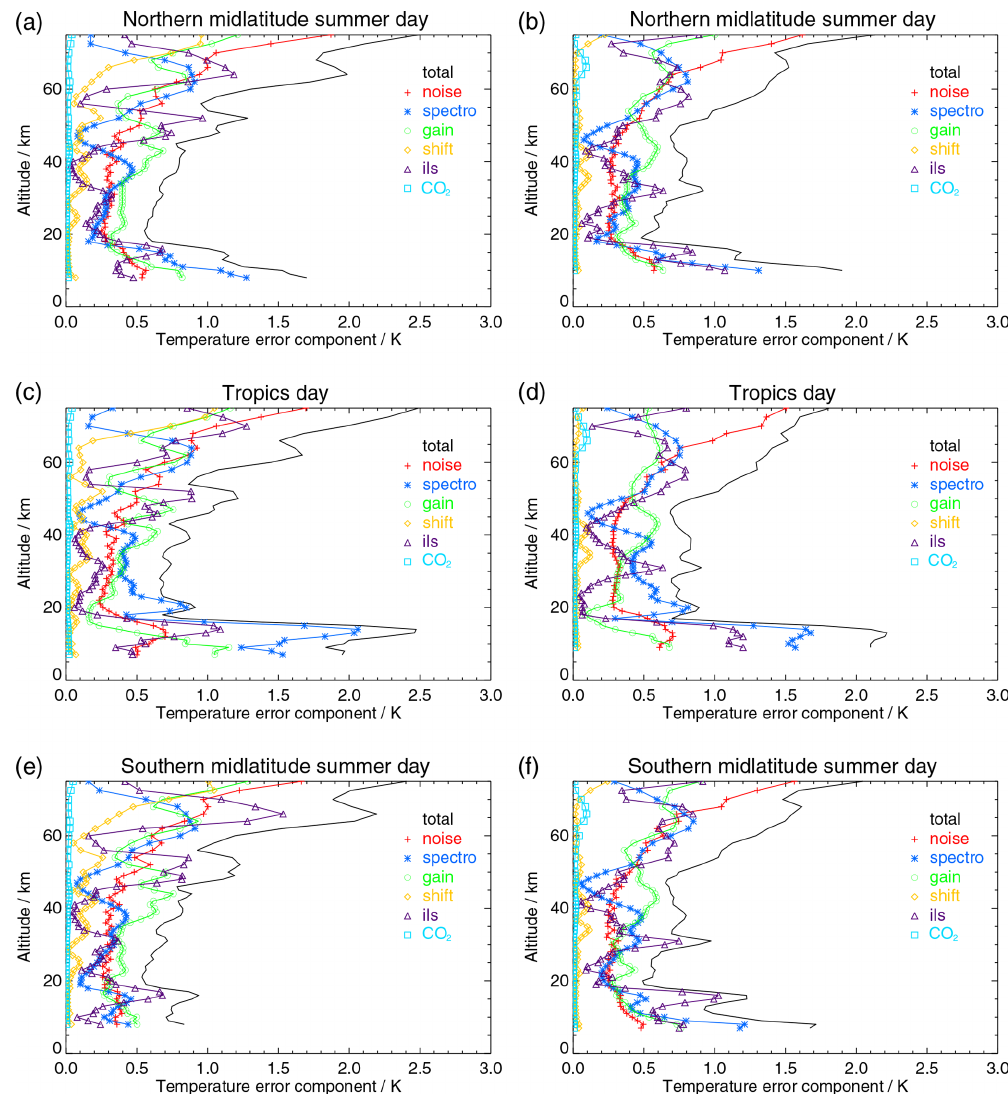
Figure 2. Temperature error budget for FR data (a, c, e) and RR data (b, d, f) with color-coding as in Fig. 1: (a, b) northern midlatitude summer day, (c, d) tropical day, and (e, f) southern midlatitude summer day. All error estimates are 1- σ